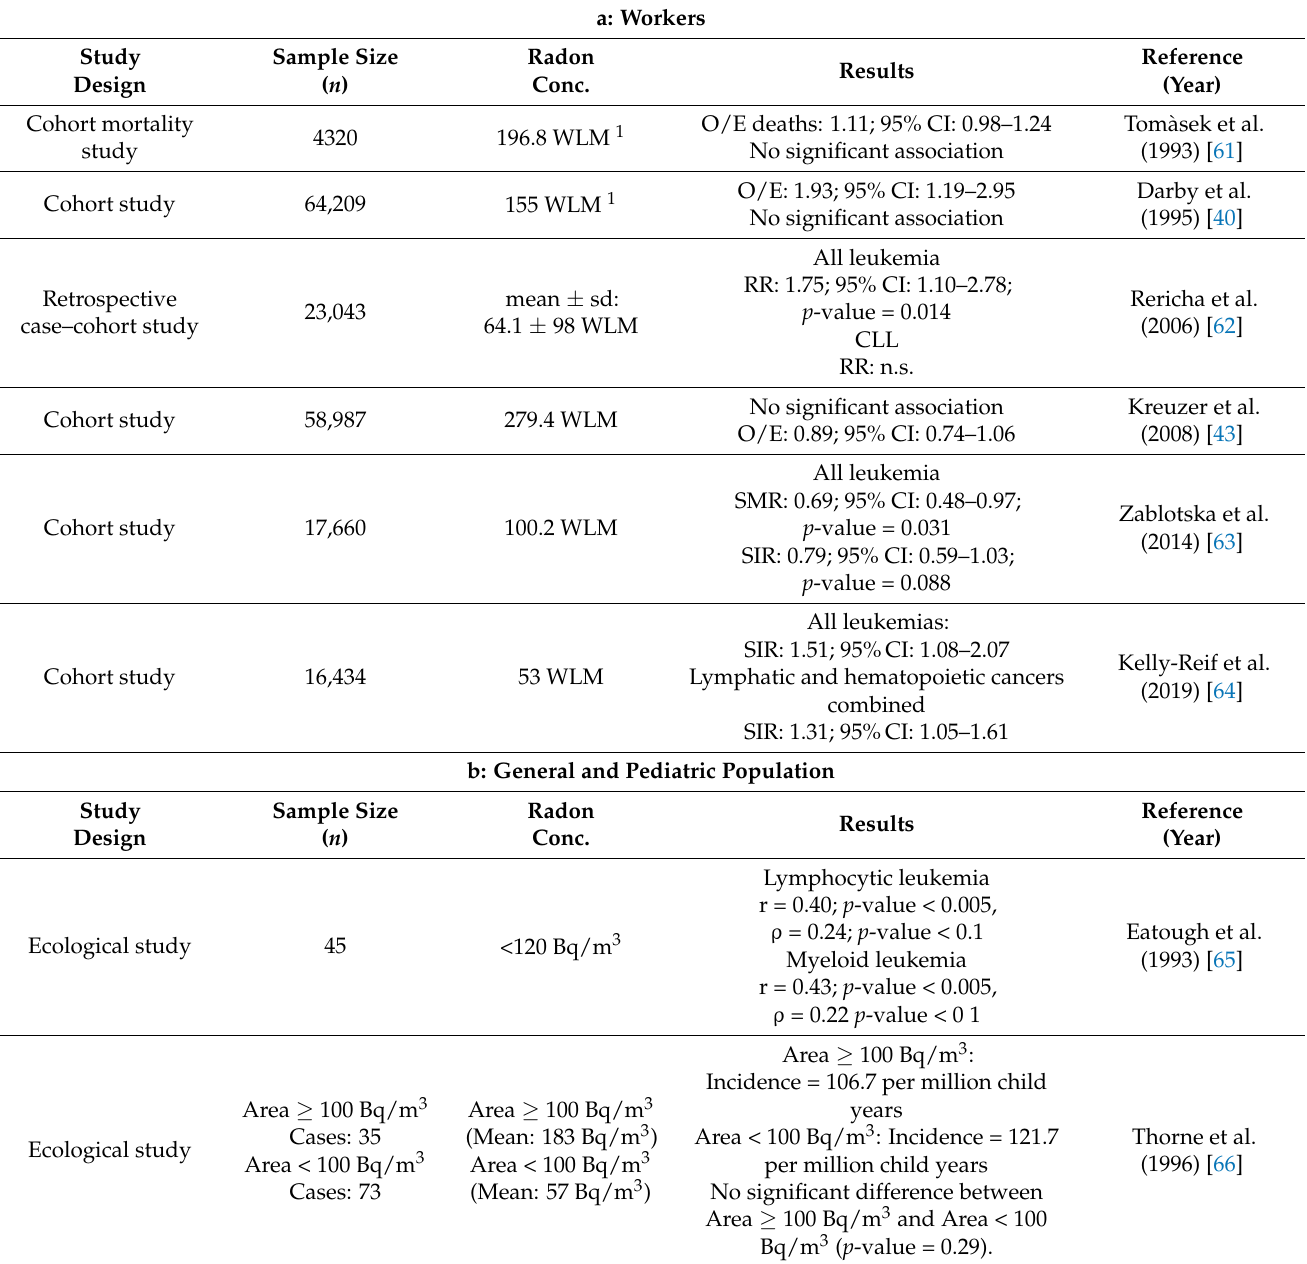
Table 2. Radon exposure and